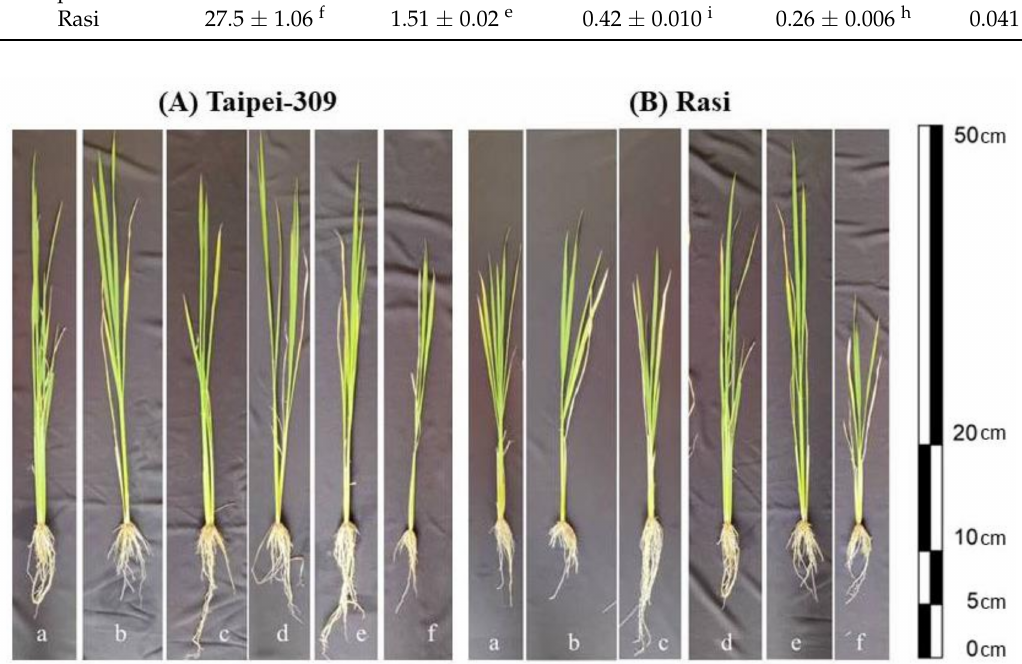
Figure 1. The influence of foliage treated with ethephon (a) 0 mM, (b) 0.4 mM, (c) 0.8 mM, (d) 1.2 mM, (e) 1.6 mM, and (f) 2.0 mM at 15 DAS on plant morphology in rice ( Oryza sativa L.) cultivars ( A ) Taipei- 309 and ( B ) Rasi at 30 DAS. DAS, days after